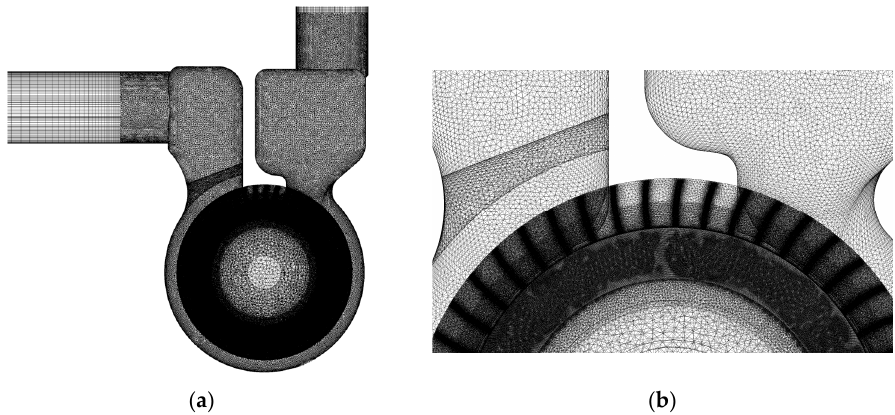
Figure 7. Grid system: ( a ) overall view; ( b ) impeller part.